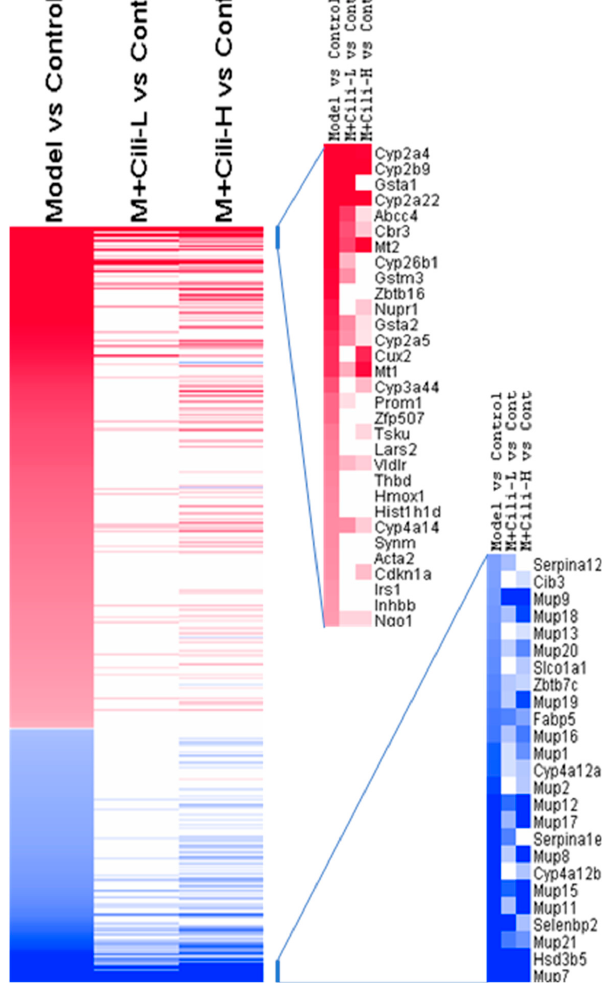
Figure 6. Heatmap comparison of DEGs based on Model vs Control groups. Red indicates increased expression and blue indicates decreased expression. The scale bar was +3/ − 3 Log2 Fold change. The entire DEGs are provided as Supplementary Table S2.